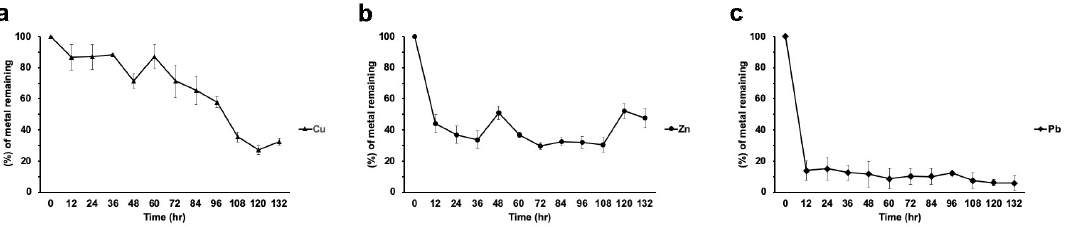
Figure 6. Metal removal from liquid cultures by strain H21. ( a ) Copper, ( b ) zinc, ( c ) lead. All treatments were tested in triplicate. Data is presented as the average amount of metal remaining in the media (%) ± standard deviation (error bars).